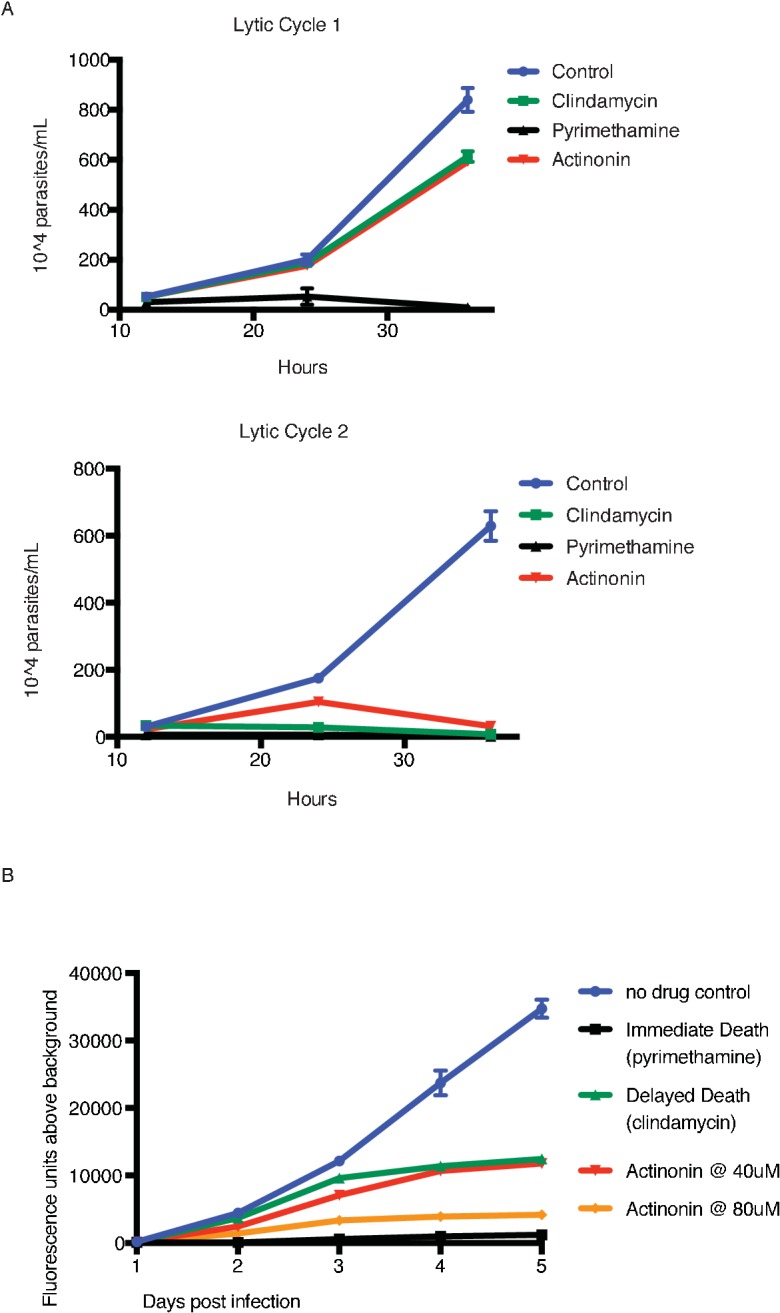
Actinonin treatment causes ‘delayed death’ in T. gondii associated with apicoplast loss.(A) Time course of parasite growth of untreated (blue), clindamycin (green), pyrimethamine (black), or actinonin (red) treated parasites over the course of two lytic cycles. Unlike P. falciparum, T. gondii undergoes multiple replication cycles in the host cell before lysis, thus each T. gondii lytic cycle represents multiple parasite replication cycles. Pyrimethamine inhibits parasite dihydrofolate reductase and was used as a control for a non-apicoplast targeting drug that inhibits growth in a single lytic cycle. As previously reported (Camps et al., 2002), clindamycin, an apicoplast translation inhibitor, gave a ‘delayed death’ phenotype in T. gondii characterized by completed cell divisions and host re-invasion during drug treatment in the first lytic cycle, followed by halted cell division in the second lytic cycle. Actinonin also led to growth inhibition in the second lytic cycle, suggesting that it also targets the apicoplast. Error bars represent the SEM of two biological replicates. It is important to distinguish between apicoplast-associated ‘delayed death’ in P. falciparum and that in T. gondii. In T. gondii, apicoplast loss occurs in the first lytic cycle and is temporally separate from defects in parasite cell division and growth inhibition observed in the second lytic cycle; whereas in P. falciparum defects in apicoplast biogenesis, parasite cell division, and growth inhibition all occur in the second replication cycle. ‘Delayed death’ in T. gondii therefore appears more broadly associated with disruption of apicoplast biogenesis, where ‘delayed death”in P. falciparum appears more specific to disruption of apicoplast gene expression that leads to delayed biogenesis defects. (B) To determine dose-dependent drug target specificity, we used a previously described fluorescent growth assay to quantify the kinetics of death in T. gondii (Gubbels et al., 2003). Briefly, T. gondii expressing tandem-tomato are treated with drug and fluorescence is quantified daily as a proxy of parasite replication. While 40 uM actinonin leads to delayed-death kinetics similar to clindamycin, 80 uM actinonin results in immediate death kinetics similar to pyrimethamine, indicating that at this concentration, actinonin hits a second, non-apicoplast target.